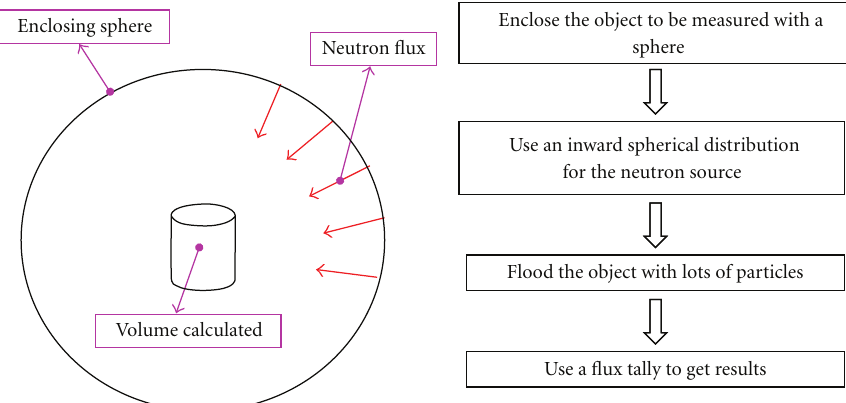
Figure 8: Stochastic cell volume procedure by MCNP5